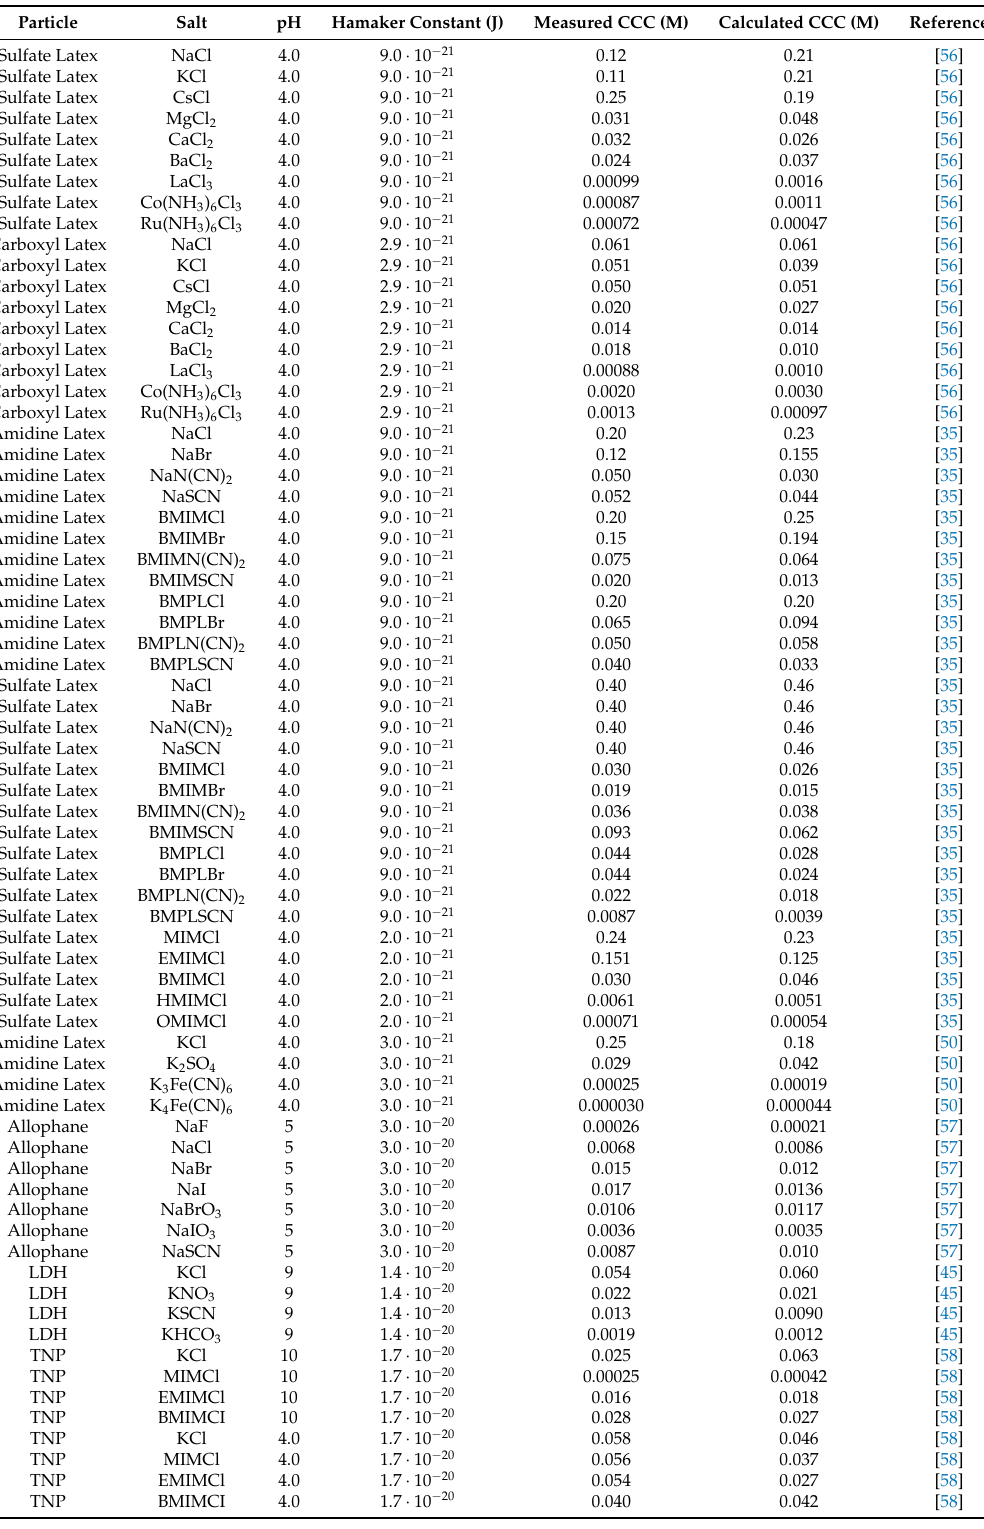
Table A1. Table with details of the systems analyzed in the present paper. All the calculated and measured CCCs are